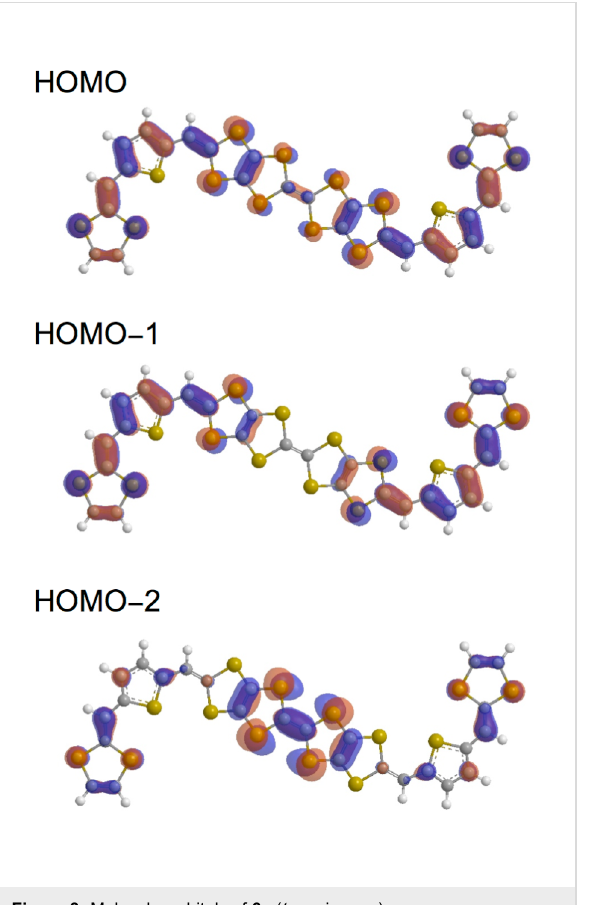
Figure 3: Molecular orbitals of 6a ( trans isomer).